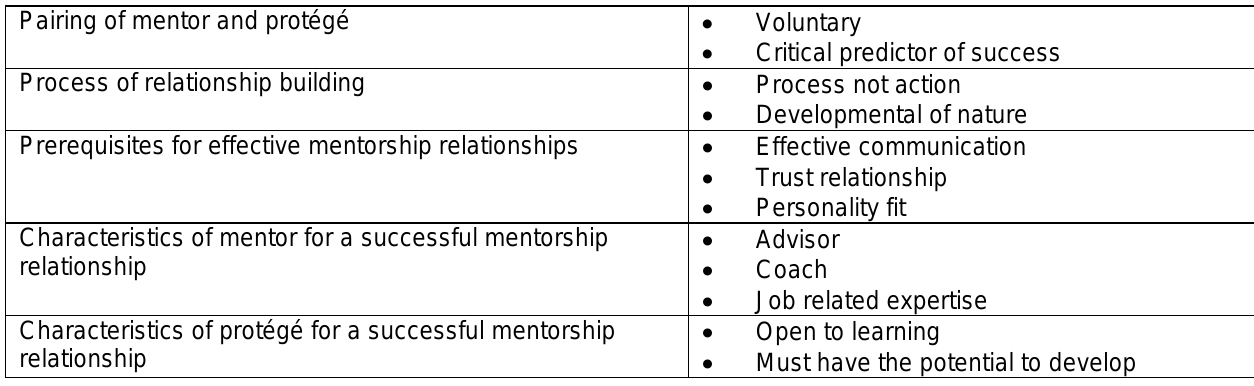
Table 2. Aspects related to mentorship relationships Pairing of mentor and